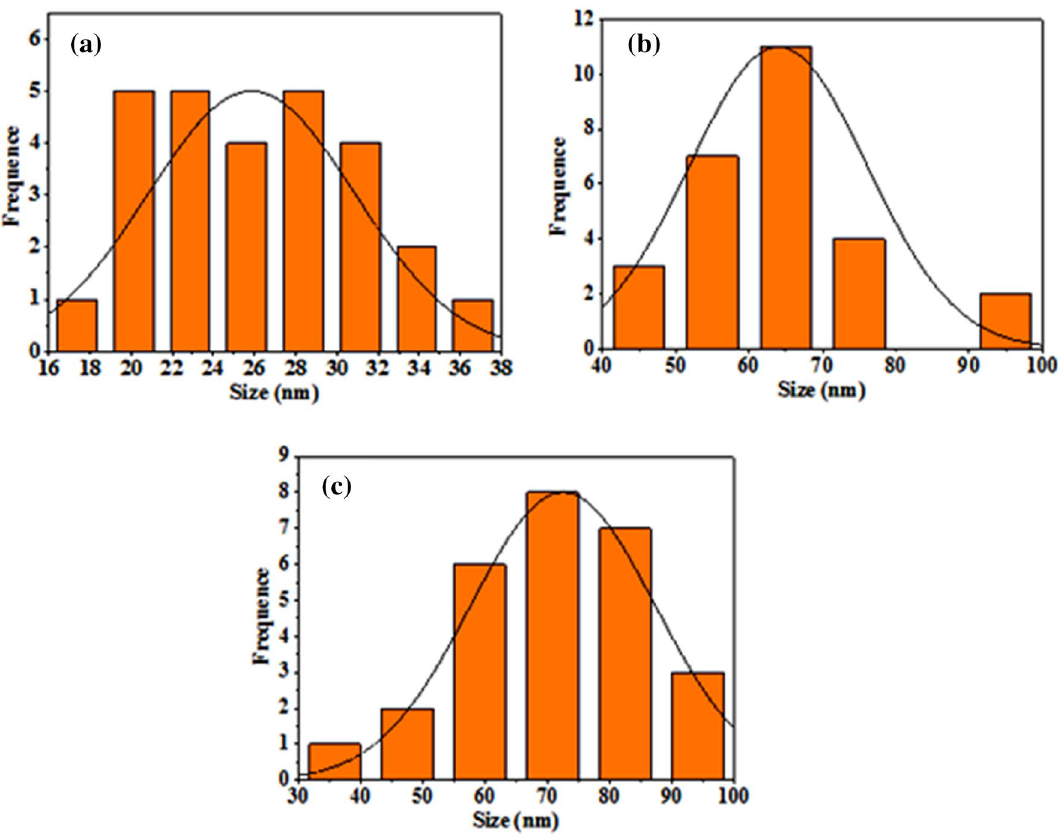
Figure 6. PSD of B4C NPs prepared with ( a ) 500, ( b ) 1000, and ( c ) 1500